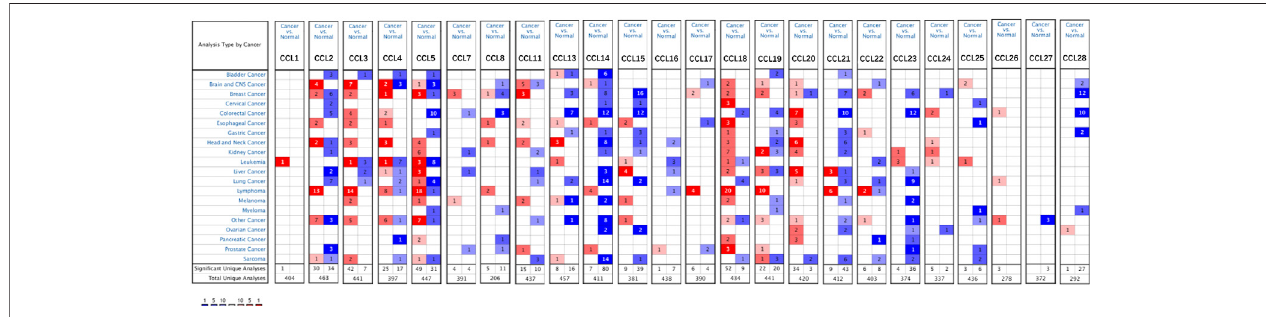
FIGURE1| mRNAlevelsofchemokinesCCLinLIHC(ONCOMINE).The fi gureshowsthenumbersofdatasetswithstatisticallysigni fi cantmRNAupregulated(red) or downregulated expression (blue) of chemokines CCL.